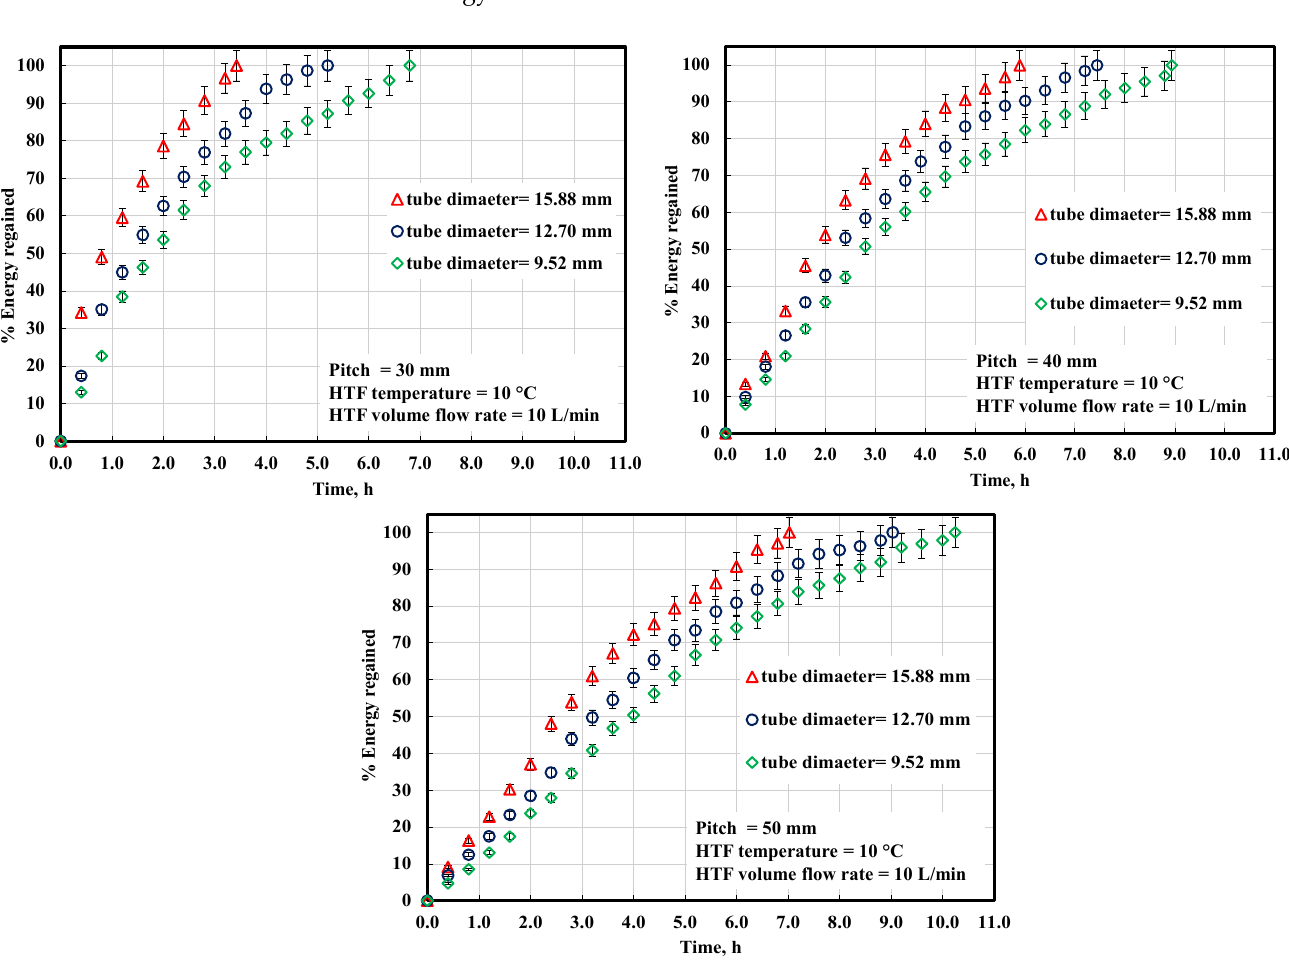
Figure 8. Effect of tube diameters on the energy regained percentage versus time using three pitches during the discharging process.